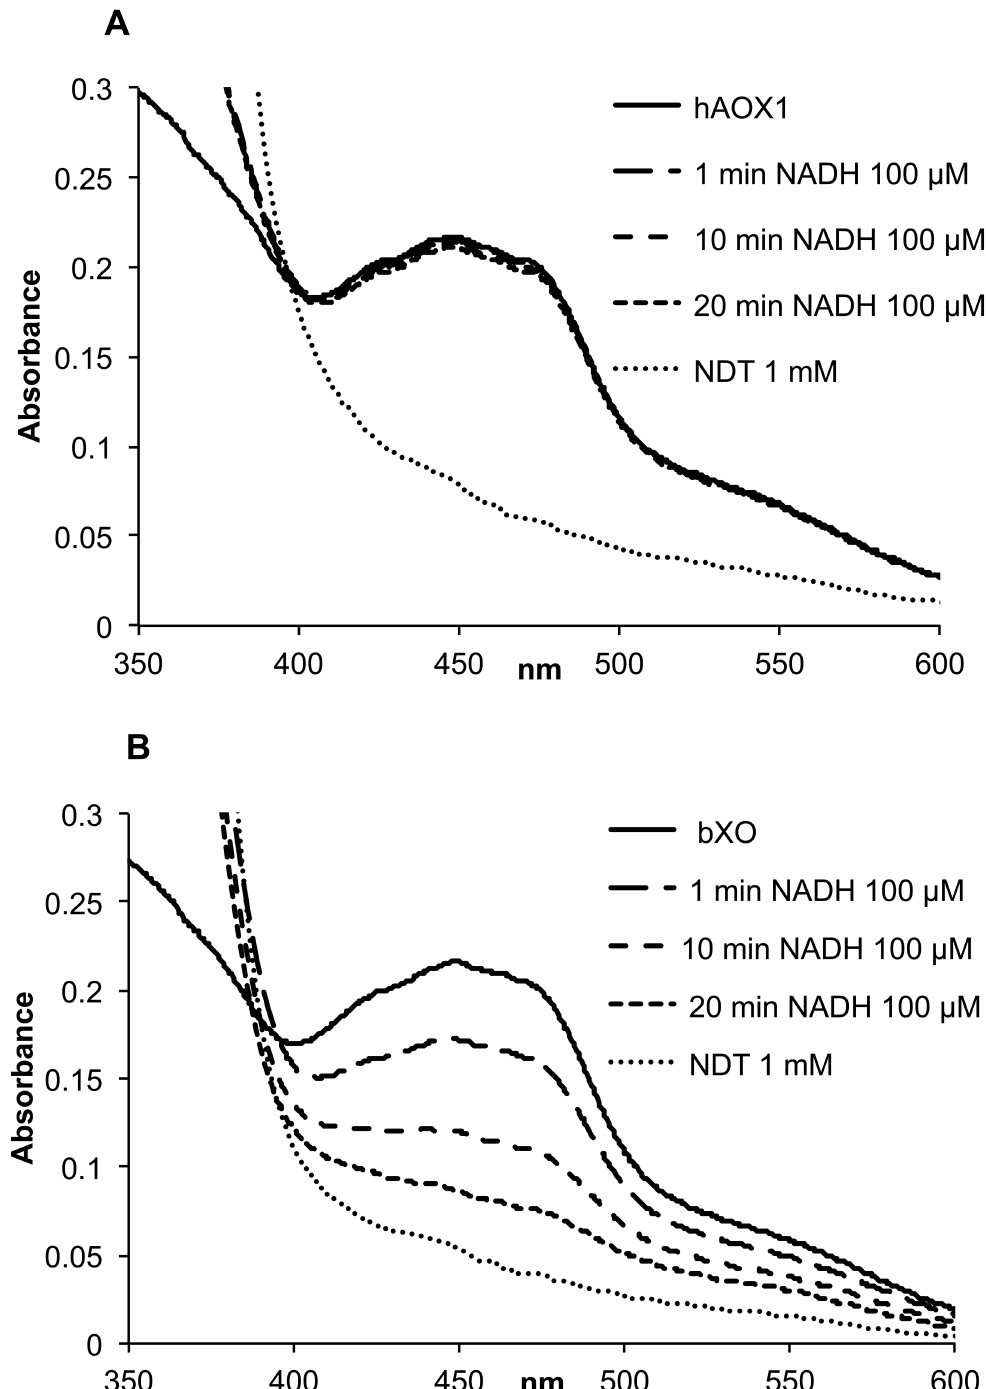
Fig 5. UV-Vis spectraof hAOX1 in comparison to bXO reduced with NADH under anaerobic conditions. The figure illustrates UV-Vis spectra of 10 μ M hAOX1 and 10 μ M bXO in the oxidizedstate (solid line) and reduced enzyme with 0.1 mM NADH after 1 min, 10 min and 20 min (dashedlines) and of the enzyme reducedwith 1 mM sodium dithionite(NDT) (dotted line). The spectra were recordedin 50 mM Tris, pH 8.0.